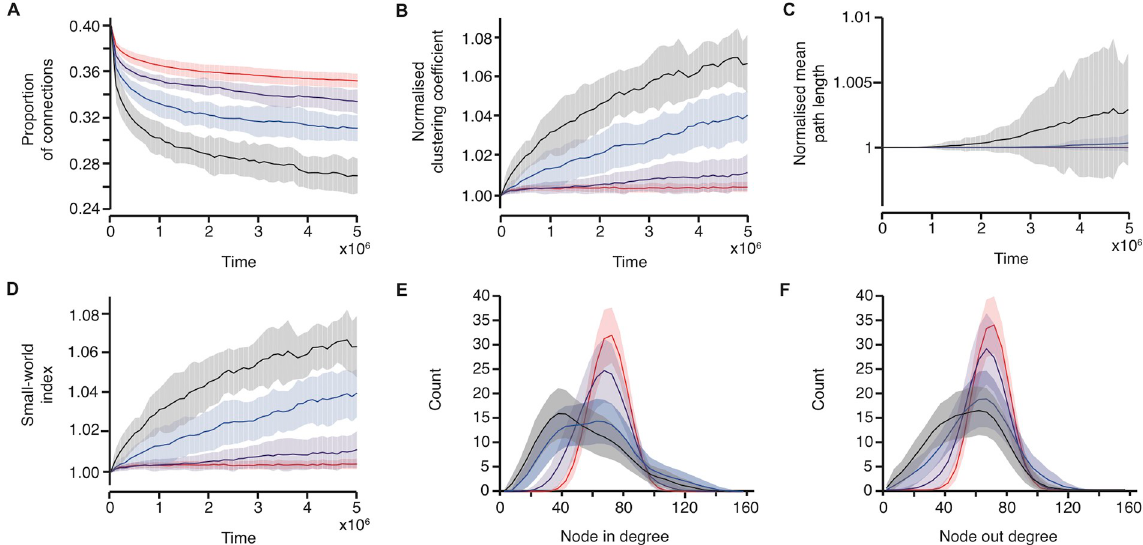
Fig 3. The speed of network evolution is related to the Hurst exponent of the driving input. Changes in network parameters with the networks driven by burst input with temporal correlations with different Hurst exponents: H � 0.5 (red), H � 0.6 (purple), H � 0.7 (blue, same simulations as in Fig 2), and H � 0.8 (black). (A) The proportion of connections in the network, (B) the normalised clustering coefficient, (C) the normalised mean path length (note for H � 0.5 and 0.6 the mean path length is equal to one throughout) and (D) the small-world index, across the course of the simulations. (E) The average in degree distributions at the end of the simulations. (F) The average out degree distributions at the end of the simulations. The solid lines indicate the mean across 20 simulations, and the shaded area the standard deviation.